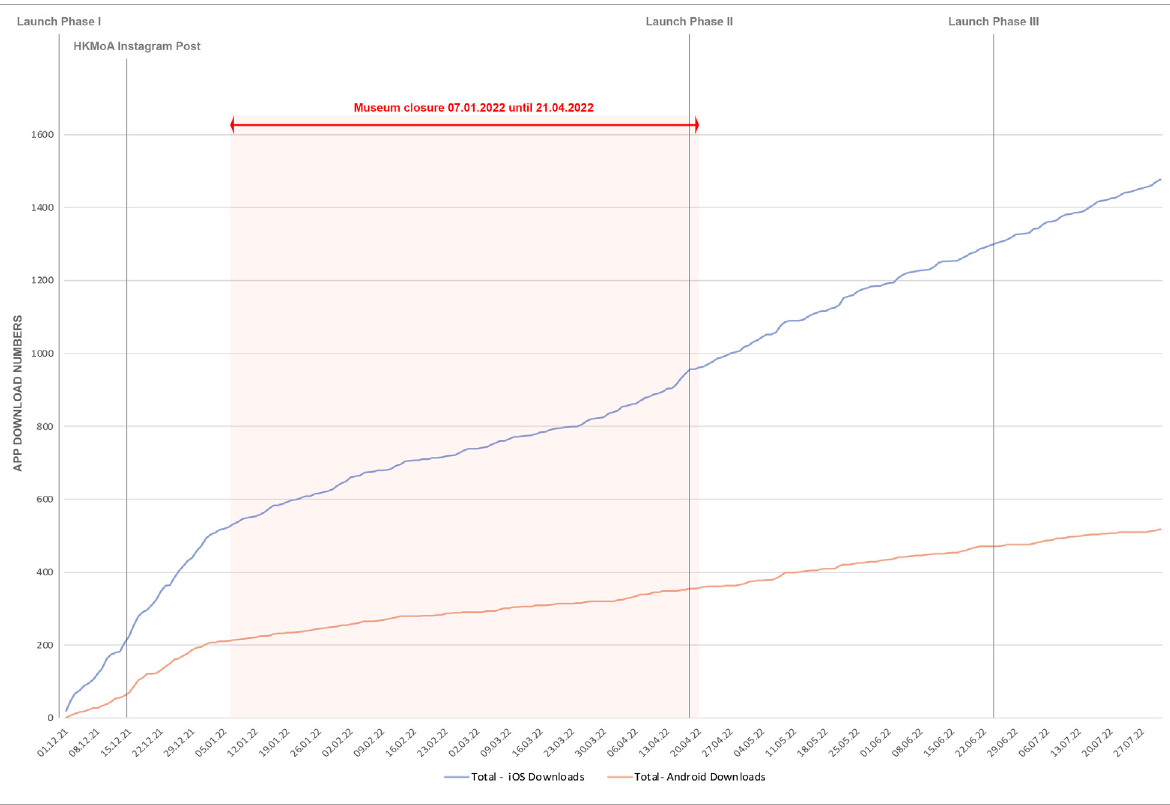
TABLE 3 Cumulative App Downloads for iOS and